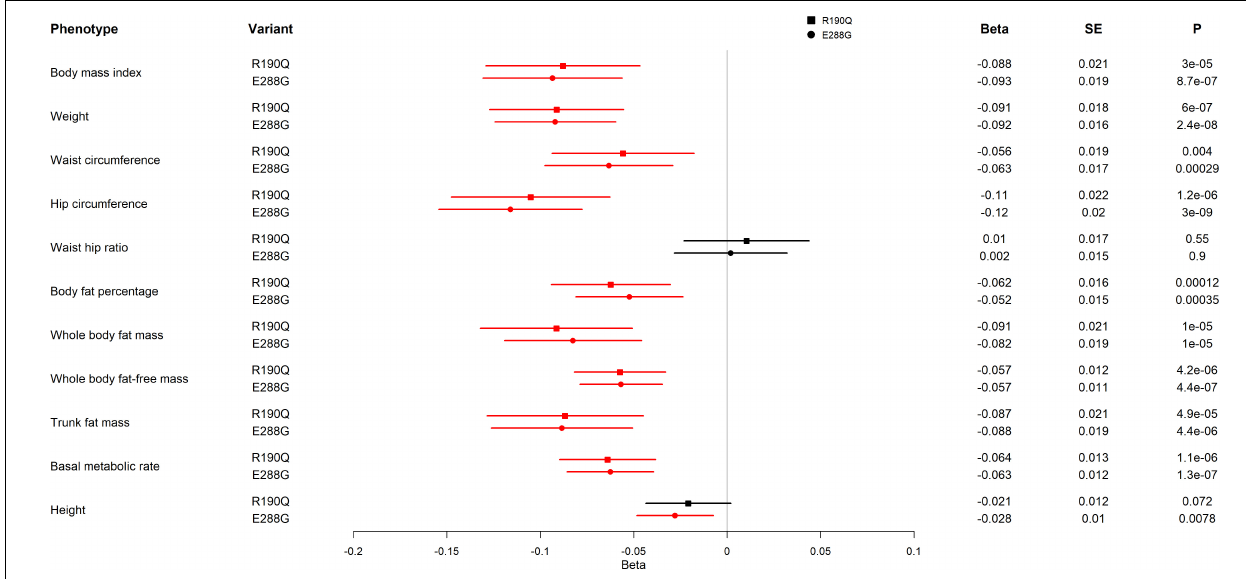
FIGURE 3 | Association of GIPR R190Q and E288G variants with adiposity-related measurements in UK Biobank. For each variant, beta, standard error (SE), and the p -value (P) are shown. All results are from an analysis of rank normalized phenotypes. The forest plot shows the beta in SD and the 95% confidence interval. Statistically significant results are shown in red. The analyses include 452,264 individuals. The effect allele frequencies of GIPR R190Q and E288G are 0.001557 and 0.001915, respectively, corresponding to 352 and 433 carriers of the variants, respectively.